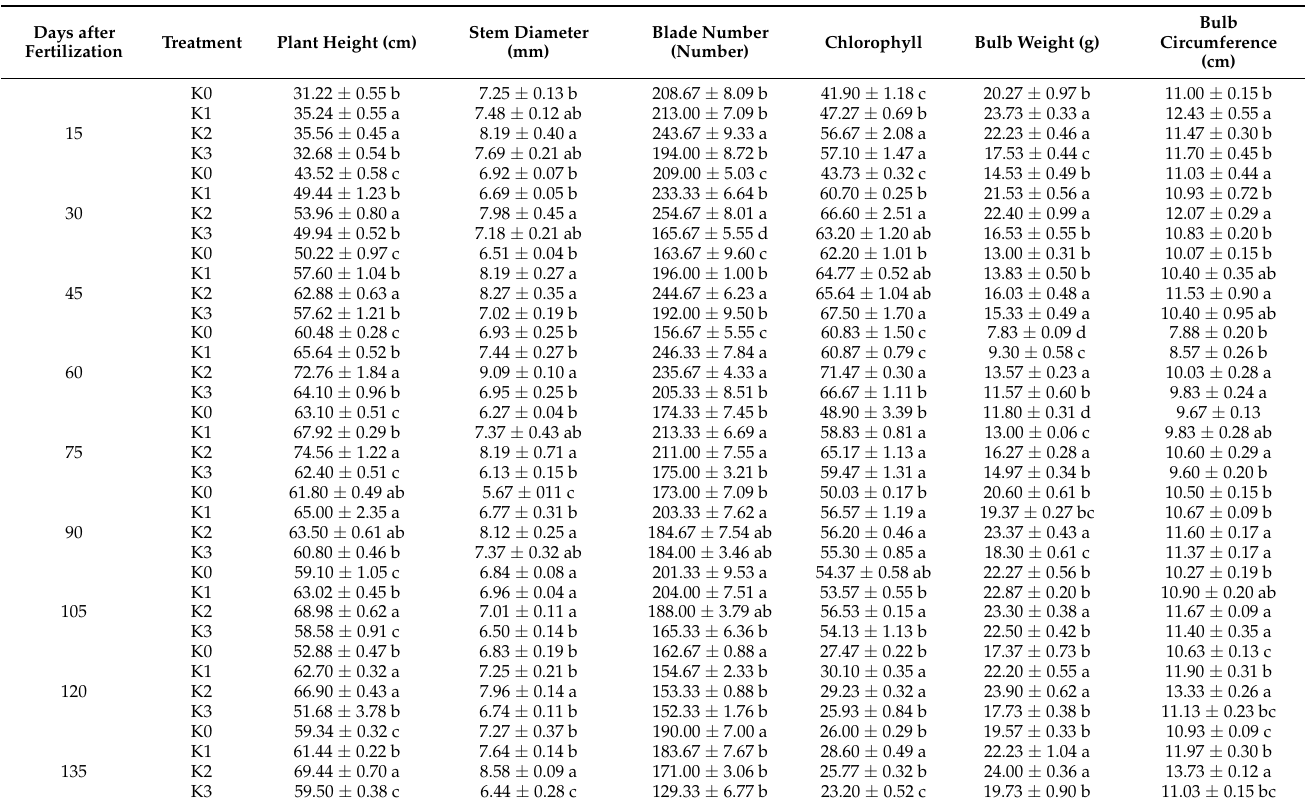
Table 2. Effects of potassium application on growth and development of L. davidii var. unicolor . Days after Fertilization Treatment